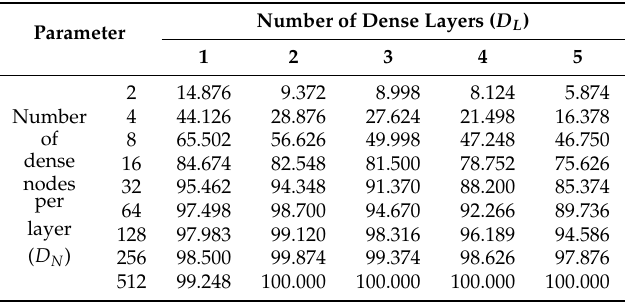
Table 7. Performance comparison of DNN according to the number of dense layers and the number of dense nodes per